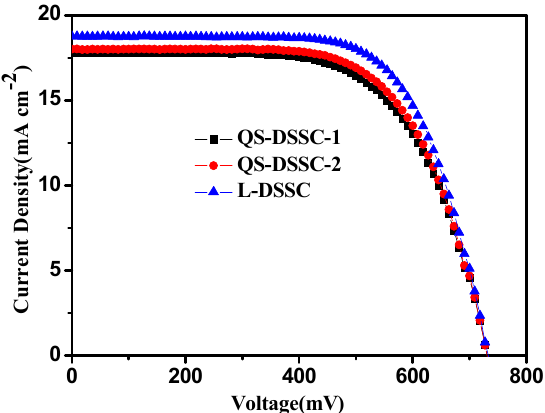
Figure 9. Photocurrent density–voltage (J–V) curves of the DSSCs with quasi-solid-state electrolytes, based on the electrospun PVDF membranes and ionic liquid electrolytes.